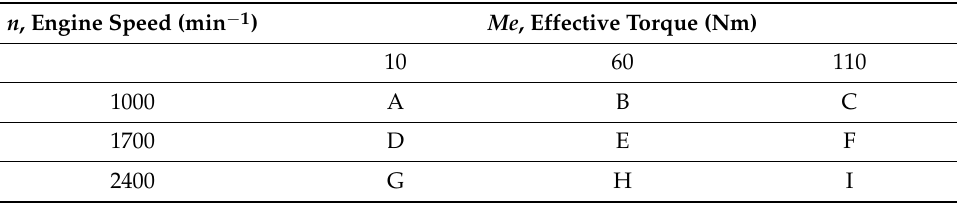
Table 3. Engine performance (torque and engine speed) in tested operating modes.